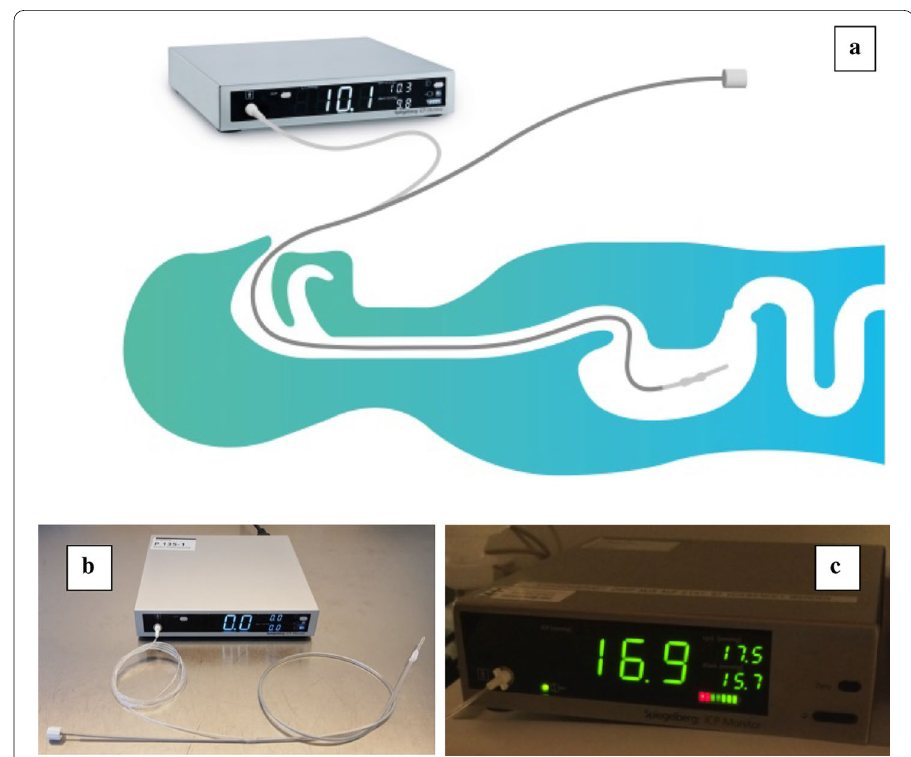
Fig. 1 Illustration of air-capsule-based intra-abdominal pressure measurement system (ACM-IGP). a Schematic illustration of the customized catheter of the air-capsule-based measurement of intra-gastric pressure (ACM-IGP) system, which is equivalent to a special double-lumen 9F nasogastric tube, inserted into the stomach and connected to an ACM-IGP monitor (Illustration courtesy of Spiegelberg Company, Hamburg, Germany). The IAP normally undulates breath-synchronously (here: minimum 9.8 mmHg in expiration, maximum 10.3 mmHg in inspiration and 10.1 mmHg on average). Respiratory variations are considered as a quality criterion for IAP measurement; their absence indicates a malposition of the ACM-IGP or bladder catheter and usually requires their reinsertion. The insertion of an ACM-IGP catheter does not differ from that of a conventional nasogastric tube and is theoretically associated with a similar risk profile (malposition with aspiration, pneumonia, pneumothorax and esophageal or gastric perforation) [23, 24]. In patients beyond infancy, the placement is facilitated by an intraluminal guidewire provided by the manufacturer. In neonates and infants, the ACM-IGP catheter was placed without a guidewire, as the narrow bendig of the rigid guidewire in the pharynx hampers a later removal in this age group. All currently available ACM-IGP catheters do not have a radiopaque contrast. Therefore, the gastric catheter location was additionally verified by abdominal sonography in the present study. b Figure illustrates the ACM-IGP catheter connected to the ACM-IGP monitor. On the right side, the white, thin-skinned air capsule (sized 10 3 2.3 mm) is displayed at the gastric end of the ACM-IGP catheter, which is used for IAP measurement. × × The opposite side is connected to the pressure transducer on the left front of the ACM-IGP monitor. In the left lower margin the guide wire for insertion of the ACM-IGP catheter is displayed on the aboral end of the second lumen. Calibration and "zeroing" of the ACM-IGP system are fully automatic and repeated once per hour in the operating mode. During the continuous IAP measurement, the air capsule is filled with a defined air volume of 0.05–0.10 ml. Any pressure applied to the air capsule from outside is registered by the pressure transducer in the monitor and displayed as IAP with a precision of one decimal. c Illustration of a representative ACM-IGP measurement in a critically ill child with intra-abdominal hypertension (IAH) grade III (IAP 16.9 mmHg). Please note that the displayed pressures with the minimum in exspiration (15.7 mmHg) = and maximum in inspiration (17.5 mmHg) represent respiratory variations of